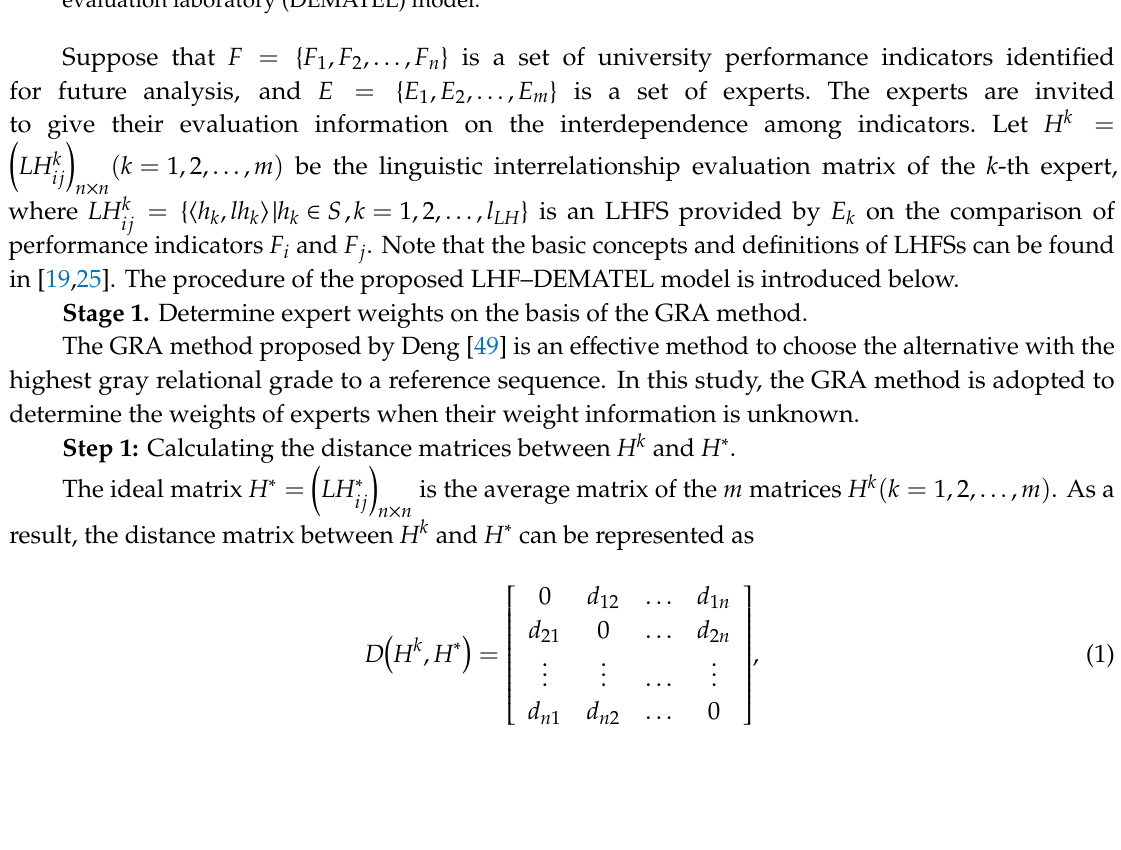
Figure 1. Flowchart of the proposed linguistic hesitant fuzzy (LHF)– decision-making trial and evaluation laboratory (DEMATEL) model.